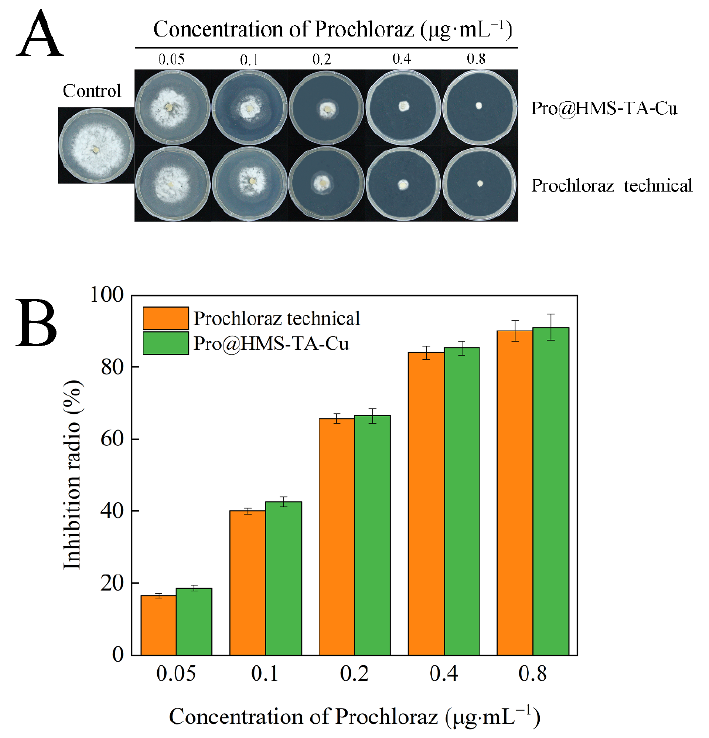
Figure 8. Images ( A ) and inhibition radio ( B ) of antifungal activity of prochloraz technical and